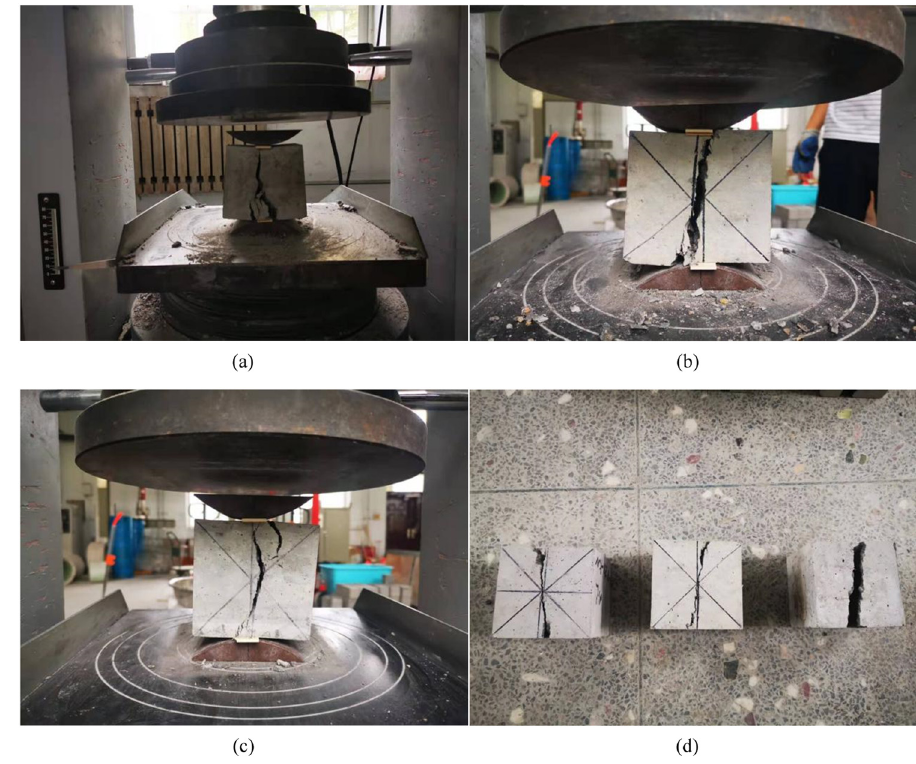
Figure 18: Splitting tensile failure modes of RAC. ( a ) RAC, ( b ) NSRAC, ( c ) BFRAC, ( d ) specimens after